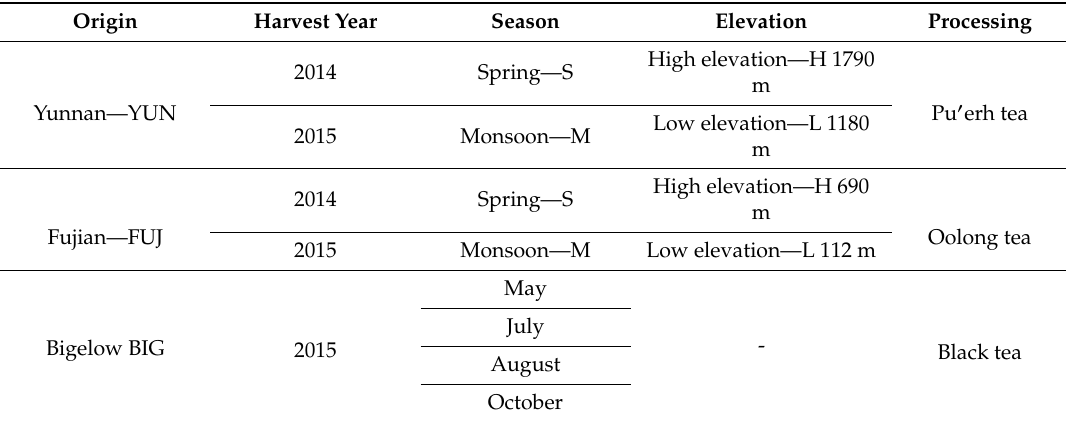
Table 2. Tea samples together with acronyms adopted in the